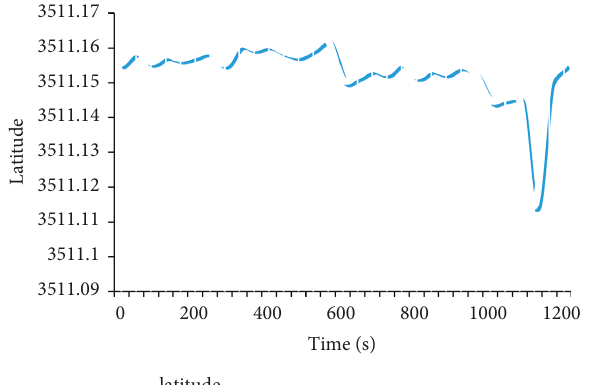
Figure 12: Changes in the relationship between latitude and time.